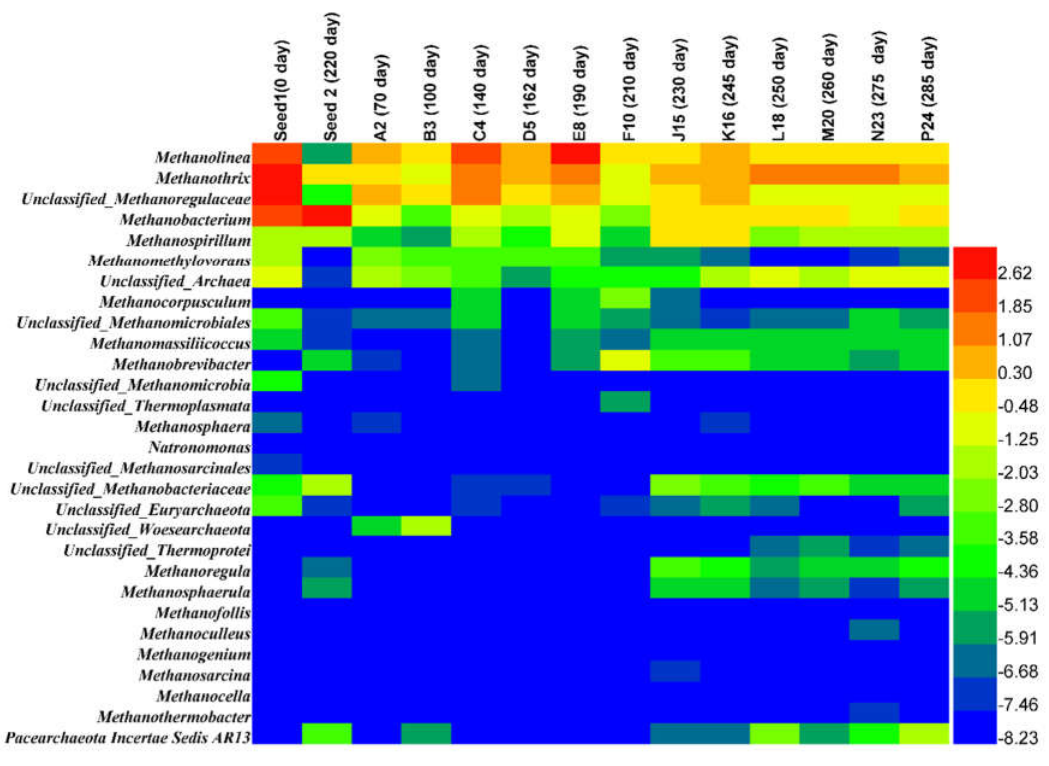
Figure 6. Heat map of Archaeal community compositions at genus level (the value values were log2 transformed).